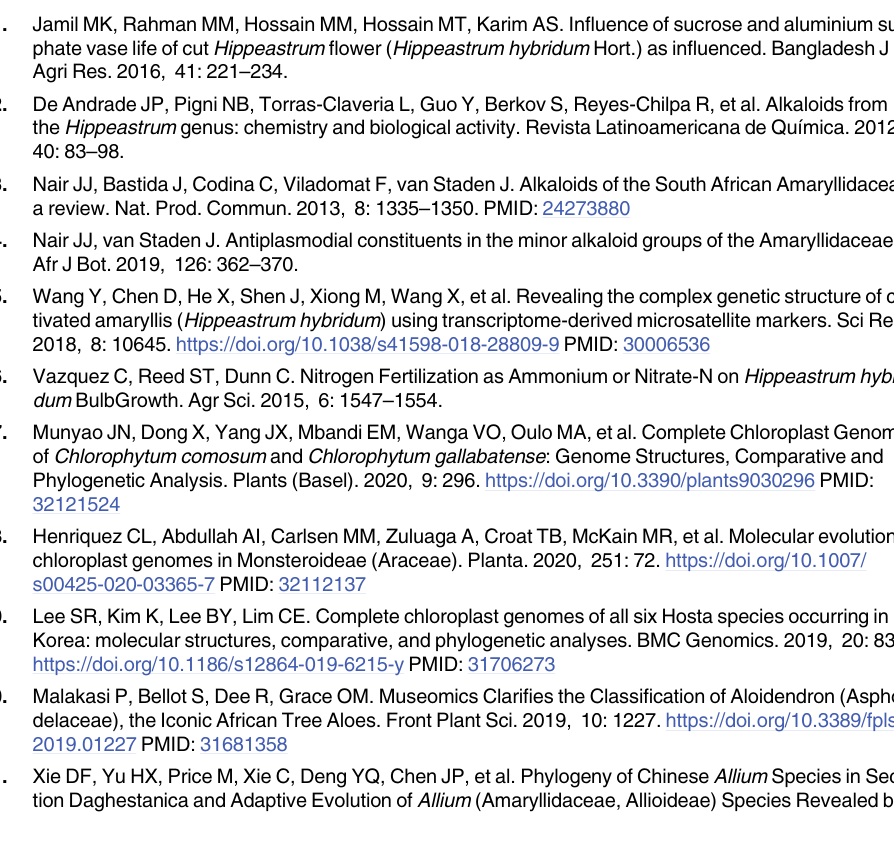
S17 Table. Ka/Ks ratios of the chloroplast genomes between H . reticulatum and Agapan- thus coddii . S18 Table. Ka/Ks ratios of the chloroplast genomes between H . reticulatum and Narcissus poeticus